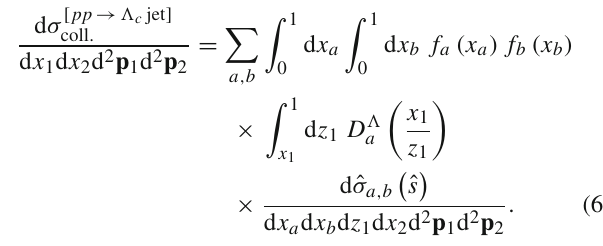
Fig. 1 Diagrammatic representation of a the double (cid:2) c and of b the (cid:2) + jet production in hybrid high-energy/collinear factorization. Red c blobs stand for proton collinear PDFs, whereas bordeaux rectangles denote baryon collinear FFs and green arrows refer to the jet selection